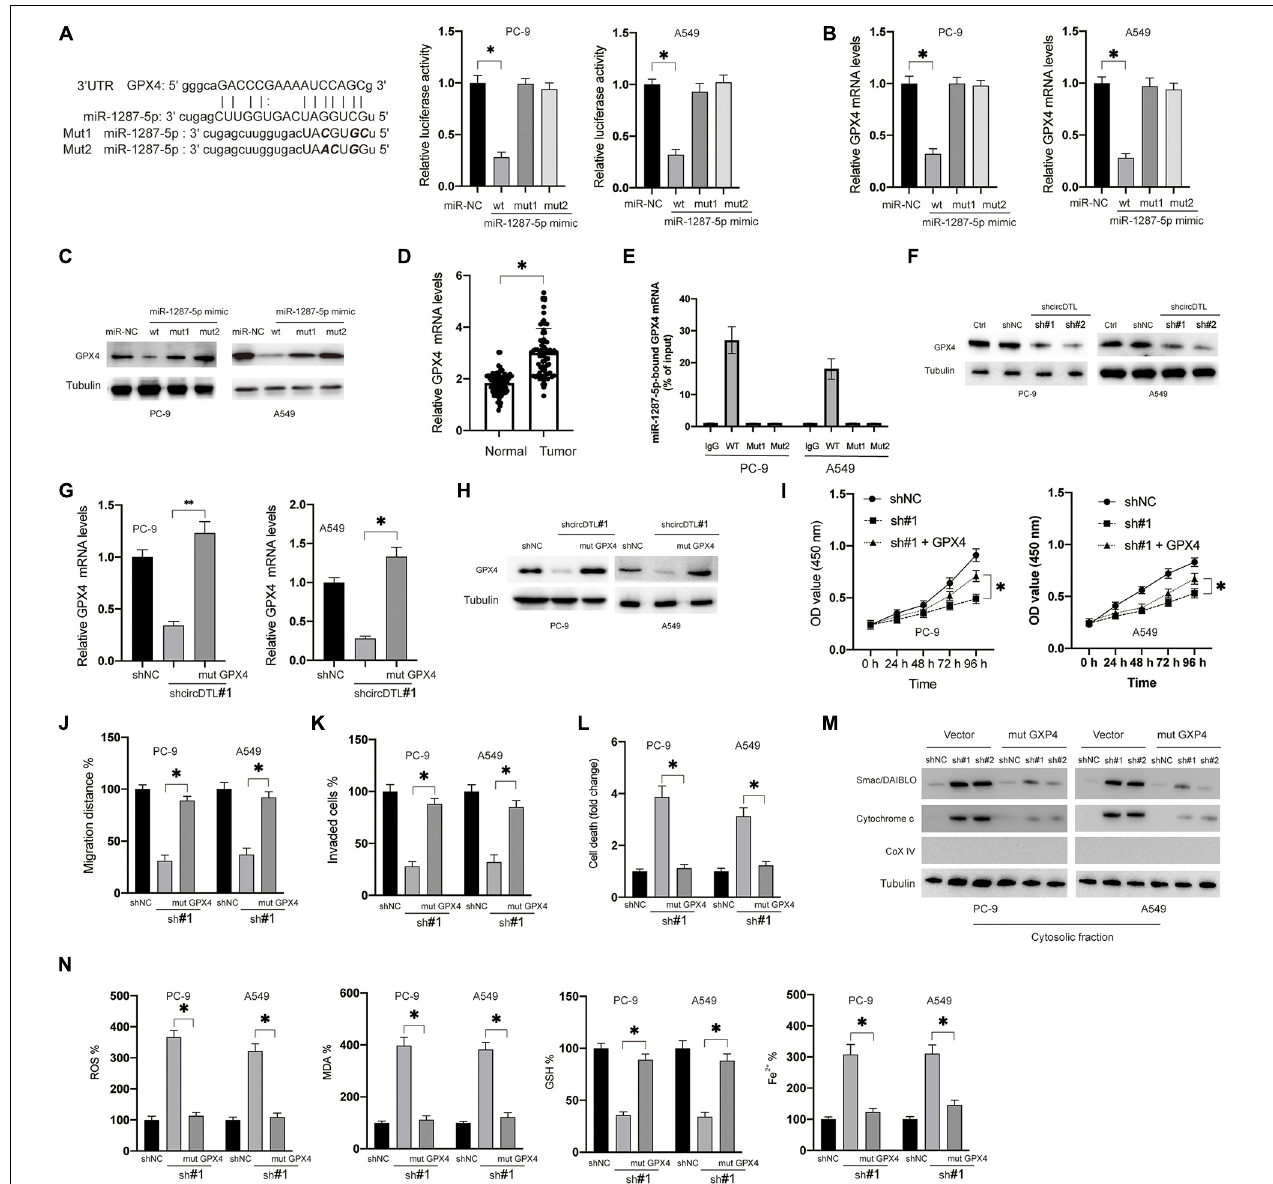
FIGURE 4 | miR-1287-5p targets GPX4 to regulate both apoptosis and ferroptosis of NSCLC cells. (A) Predictive binding sites between miR-1287-5p and 3 (cid:48) -UTR of GPX4 (left), the interaction between miR-1287-5p and 3 (cid:48) -UTR of GPX4 was evaluated by dual-luciferase reporter assay (right). (B) NSCLC cells were transfected as indicated for 24 h, mRNA levels of GPX4 were measured by RT-PCR. (C) Protein levels of GPX4 were measured. (D) mRNA levels of GPX4 were measured in NSCLC and adjacent normal tissues. (E) RNA pull-down was conducted to evaluate the GPX4 mRNA that binds with miR-1287-5p. (F) NSCLC cells were transfected with shNC or shRNAs against circDTL (sh#1, sh#2), protein levels of GPX4 were measured. (G) mRNA levels of GPX4 were measured. (H) Protein levels of GPX4 were measured. (I) Cell viabilities were measured at different time points. (J) cell migration distance was calculated. (K) Several invaded cells were measured. (L) Cell death was measured. (M) the release of mitochondrial proteins was measured. (N) Levels of ROS, MDA, GSH, and Fe 2 + were measured. Data were presented as mean ± SD. Experiments were performed at least three times. ∗ P < 0.05; ∗∗ P <